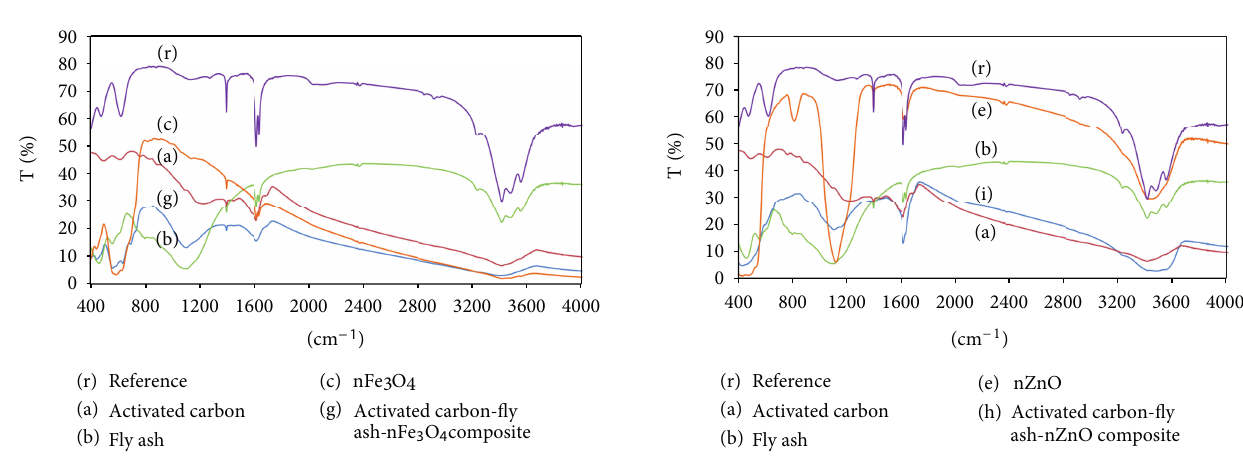
nSiO 2 Activated carbon-fly ash-nSiO 2 composite